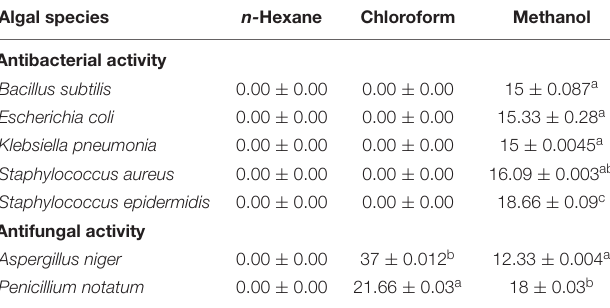
TABLE 4 | Antimicrobial activity of Padina